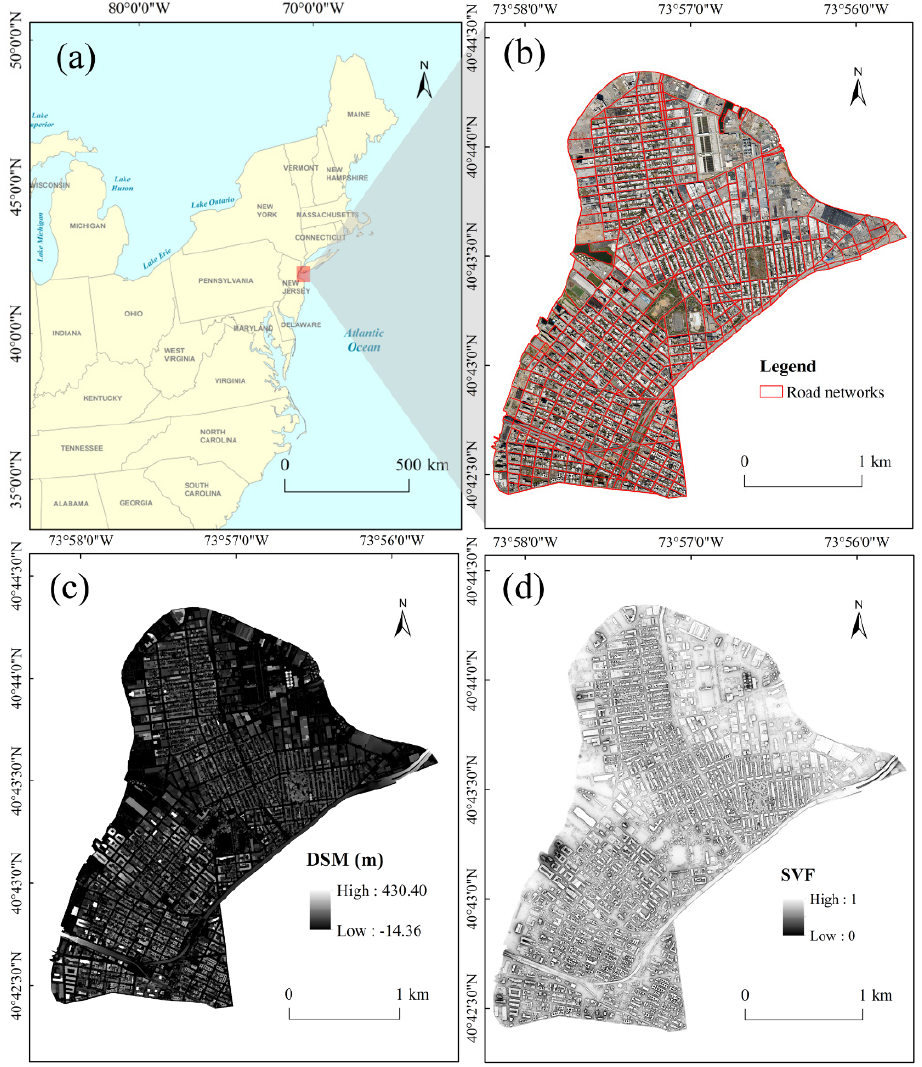
Figure 2. The overview of the study area. ( a ) location of the study area, ( b ) true color composited image, ( c ) Digital Surface Model (DSM), and ( d ) sky view factor (SVF).